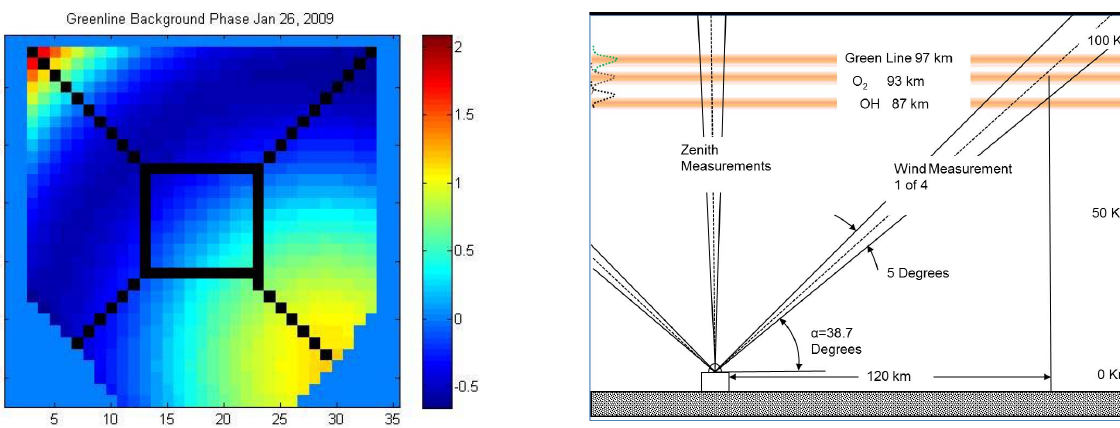
Fig. 3. Schematic of the viewing geometry of ERWIN II. This shows three fields of view. The other two are orthogonal to the plane of the